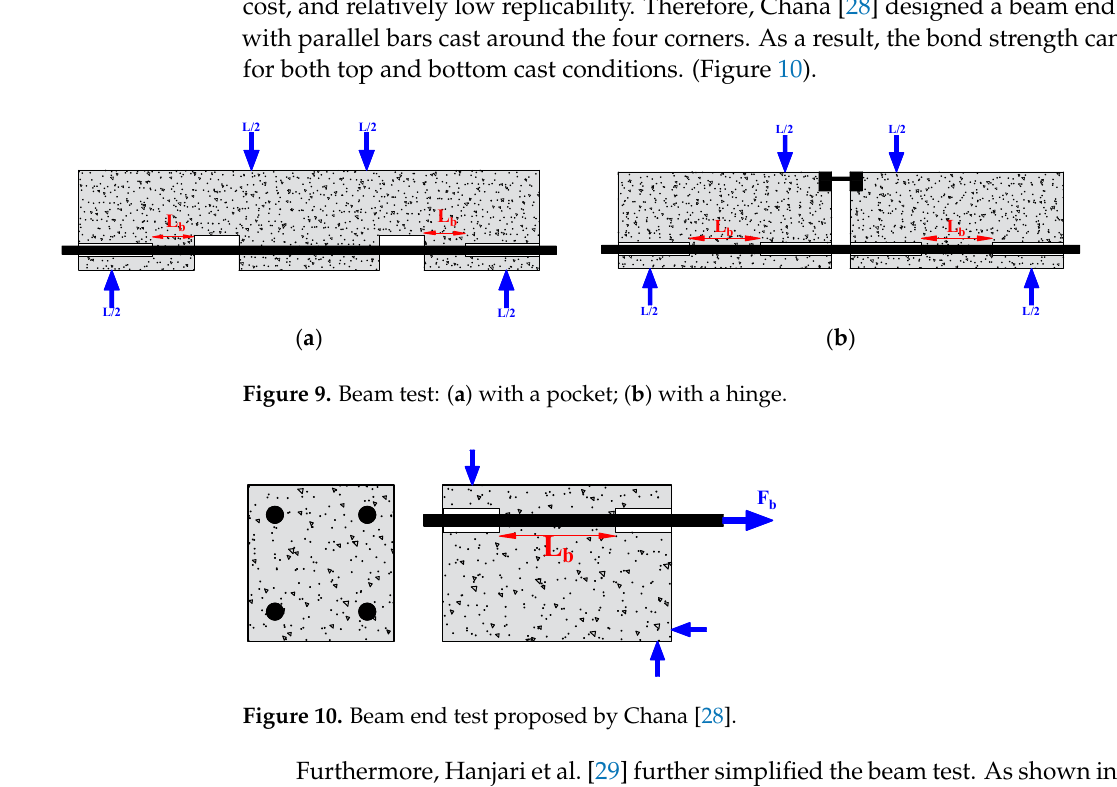
Figure 10. Beam end test proposed by Chana [28].